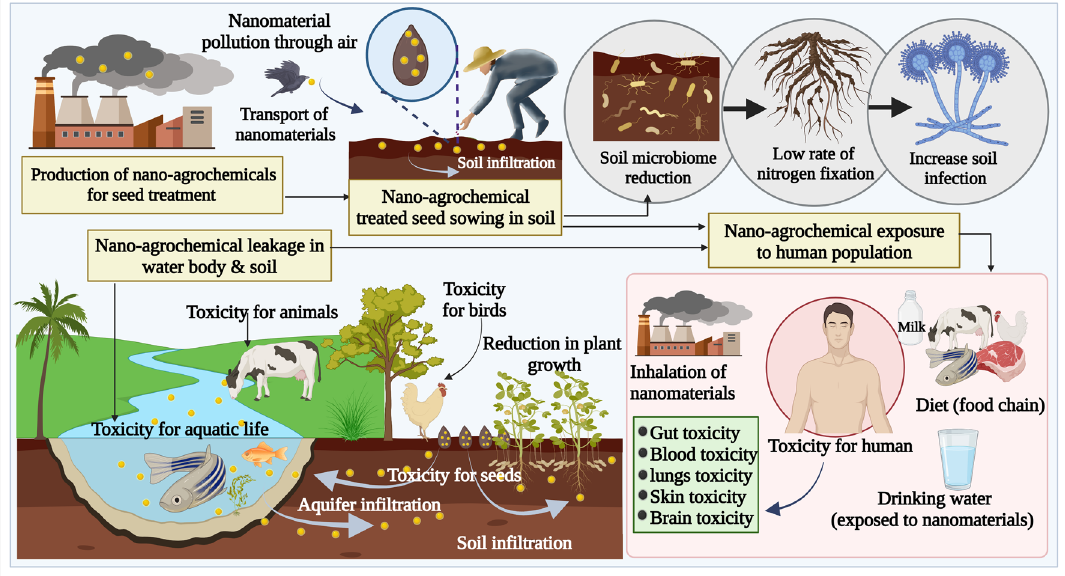
Fig. 5 Possible risks associated with nanoagrochemicals-based seed treatments (nanomaterials which made their way into wastewater and soil can contaminate water resource and increases soil pollution. A wide range of soil microbiomes and their nitrogen fixation, mineralization, and plant growth-promoting processes may adversely impact by nanomaterials. A nanomaterial can enter the body of an aquatic organism and live- stock can seep into water bodies and enter the food chain and ultimately effecting the human